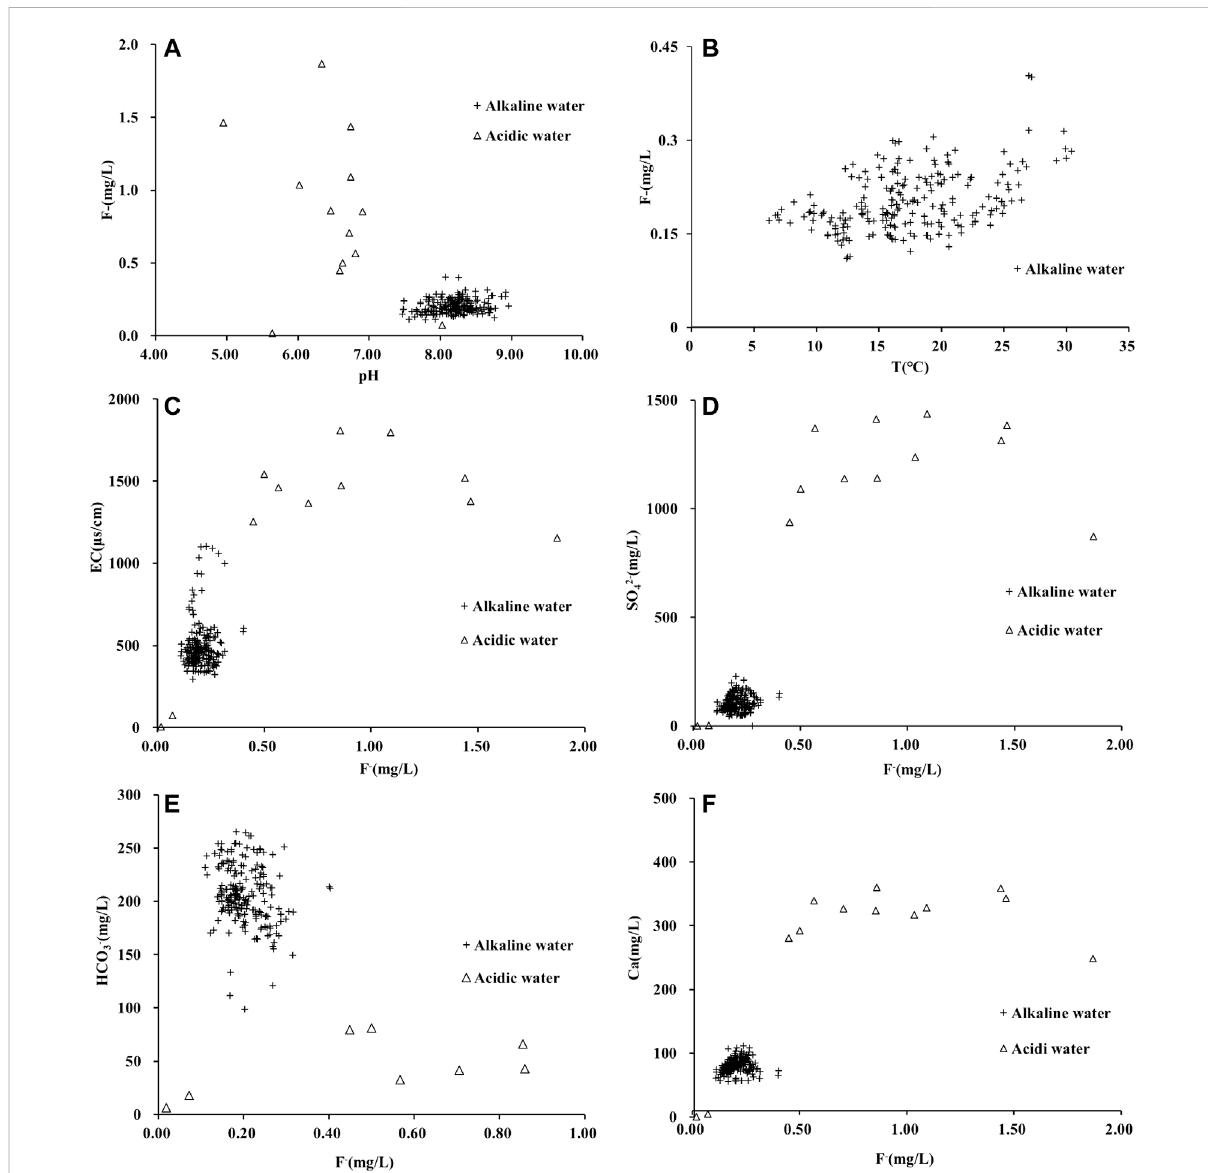
FIGURE 3 Correlation between fl uorine content and different hydrochemical parameters in Huatan River Basin. (In all subgraphs, the cross symbol represents alkaline water, and the hollow triangle represents acidic water).